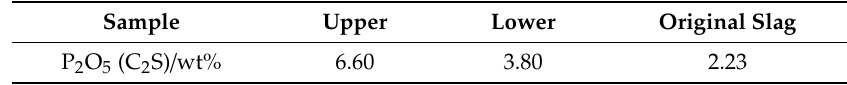
Table 5. Content of phosphorus in the upper and lower C 2 S held at 1673 K for 240 min processed at the kilo-scale.